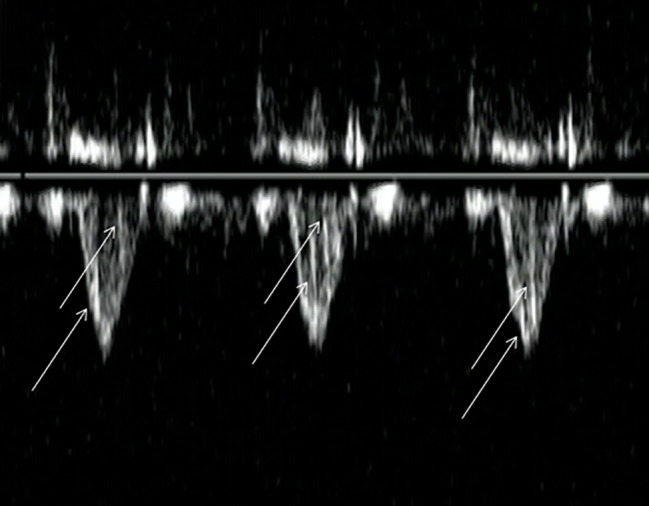
Circulating bubbles detected in the pulmonary artery blood flow: the arrows indicate bubble signals in each cycle (Grade 3: the majority of the cardiac periods contain bubble signals singularly or in group).